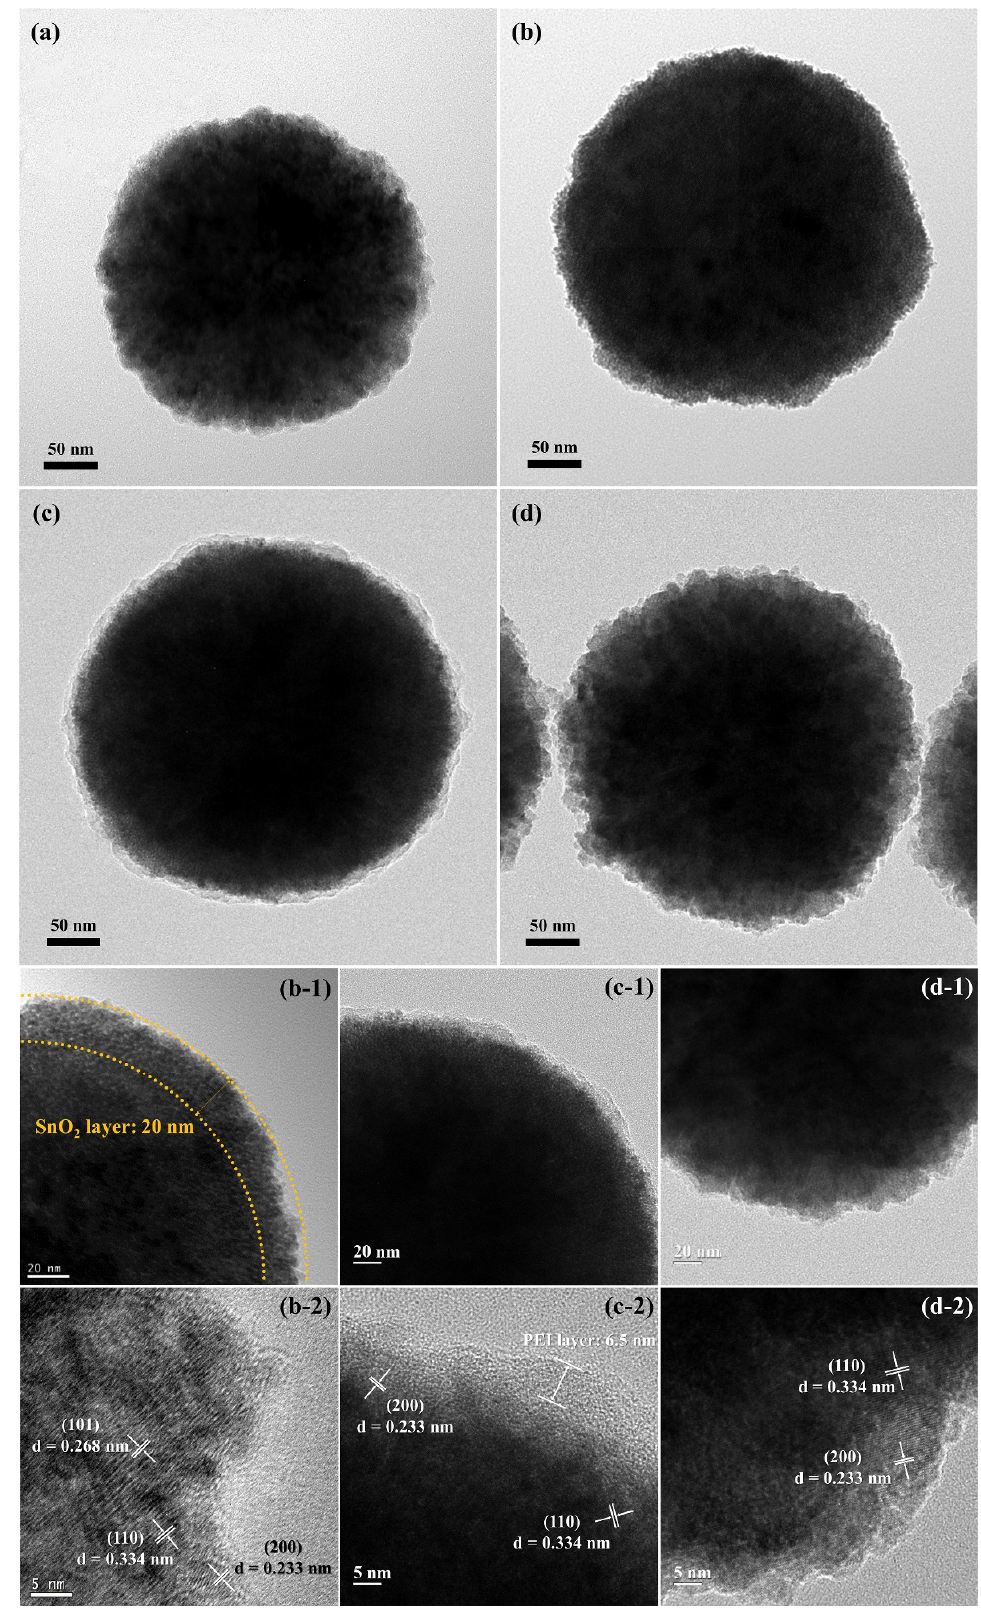
Figure 5. TEM and HRTEM images of the ( a ) as-prepared Fe 3 O 4 , ( b,b-1,b-2 ) Fe 3 O 4 -SnO 2 , ( c,c-1,c-2 ) PEI-treated Fe 3 O 4 -SnO 2 , and ( d,d-1,d-2 ) APTES-treated Fe 3 O 4 -SnO 2 nanoparticles.